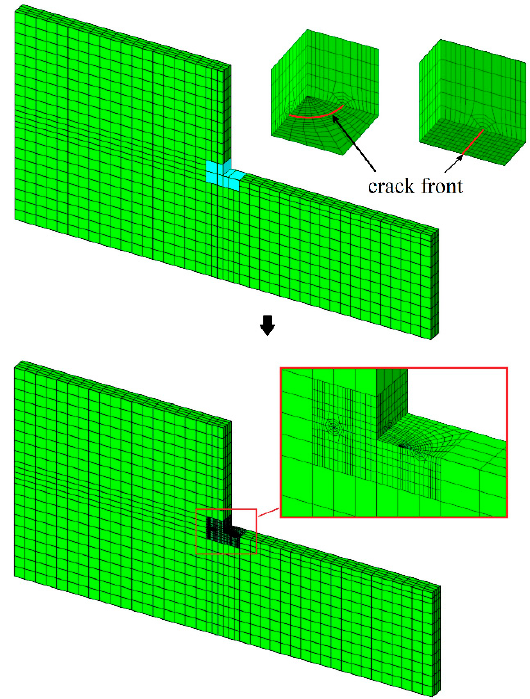
Figure 8. Process of mesh creation.